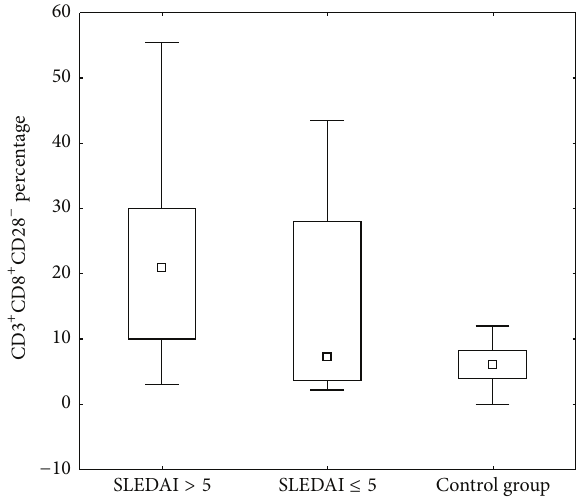
Figure 3: Comparison of the percentage of CD 3 + CD 8 + CD 28 − cells in the patients divided into two groups according to disease activity measured by SLEDAI scale and the control group.